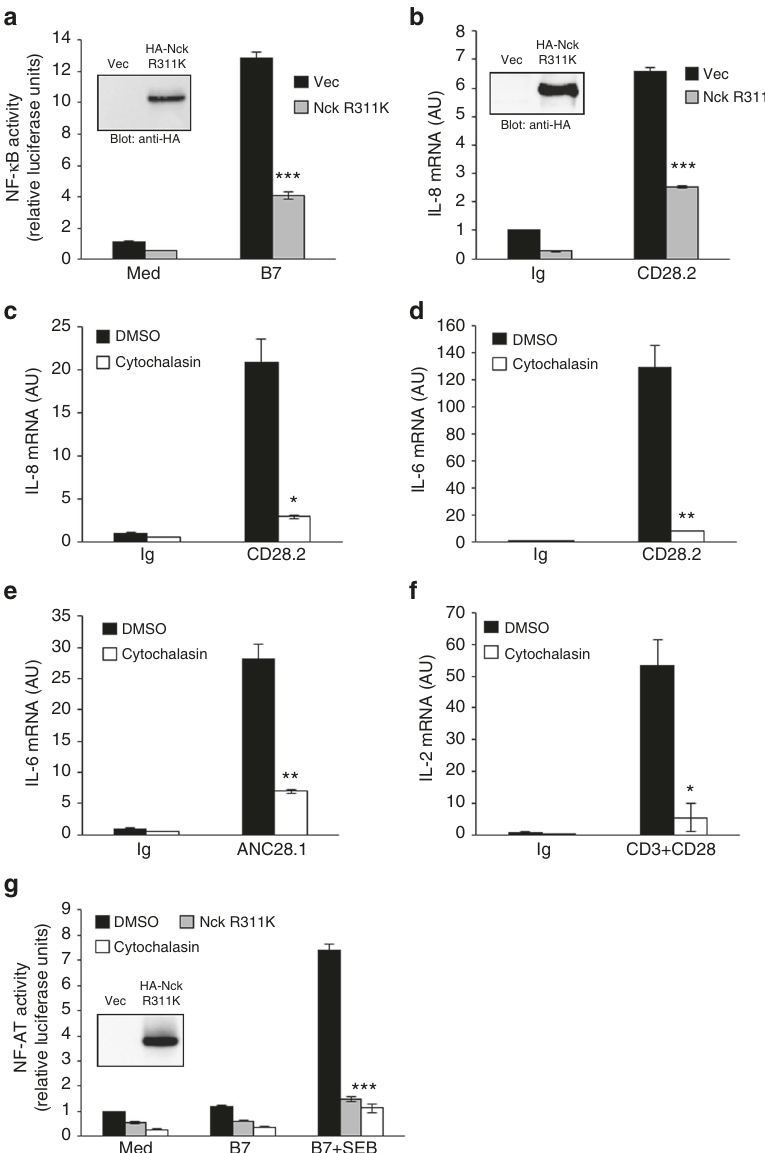
Fig. 10 Nck SH2 domain and actin polymerisation are required for CD28-mediated signalling properties. a NF- κ B luciferase activity of CH7C17 cells expressing hCD28WT transfected with empty vector (Vec) or HA-Nck R311K construct and stimulated in the presence (B7) or absence (Med) of Dap3/B7 cells. The results are expressed as the mean of luciferase units ± SD after normalisation to GFP expression. Asterisks (***) indicate p < 0.001 calculated by Student ’ s t- test compared to B7-stimulated cells transfected with empty vector. Anti-HA western blotting was performed on total lysates (insert panel). The results are representative of three independent experiments. b Primary CD4 + T cells were transfected with 2 μ g of empty vector (Vec) or HA-Nck R311K construct. Real-time PCR was used to measure IL-8 mRNA levels after stimulation with isotype control (Ig) or 2 μ g ml − 1 crosslinked anti-CD28.2 Abs. Data are expressed as arbitrary units (AU). Bars show the mean ± SD of four independent transfections. Anti-HA western blotting were performed on total lysates (insert panel). c – f Human primary CD4 + T cells were stimulated for 6 h with isotype control mAb (Ig) or 2 μ g ml − 1 crosslinked agonistic CD28.2 ( c , d ) or superagonistic ANC28.1 Abs ( e ), or 2 μ g ml − 1 crosslinked anti-CD3 (UCHT1) plus anti-CD28 (CD28.2) Abs ( f ) in the presence of 10 μ M cytochalasin D or DMSO, as vehicle control. IL-8 ( c ), IL-6 ( d , e ), and IL-2 ( f ) mRNA levels were measured by real-time PCR and values, normalised to GAPDH, expressed as arbitrary units (AU). Lines represent mean values ± SD. g NF-AT luciferase activity of hCD28 WT cells transfected with empty vector or HA-Nck R311K mutant and stimulated with medium (Med) or 5-3.1/B7 cells pre-pulsed or not (B7) with SEB (1 μ g ml − 1 ) in the presence of DMSO, as vehicle control, or cytochalasin D. The results are expressed as the mean of luciferase units ± SD after normalisation to GFP values. * p < 0.05, ** p < 0.01, *** p < 0.001 calculated by Student ’ s t- test. All data are representative of three independent erties (Fig. 10). Since Nck and Vav1 are both required for the